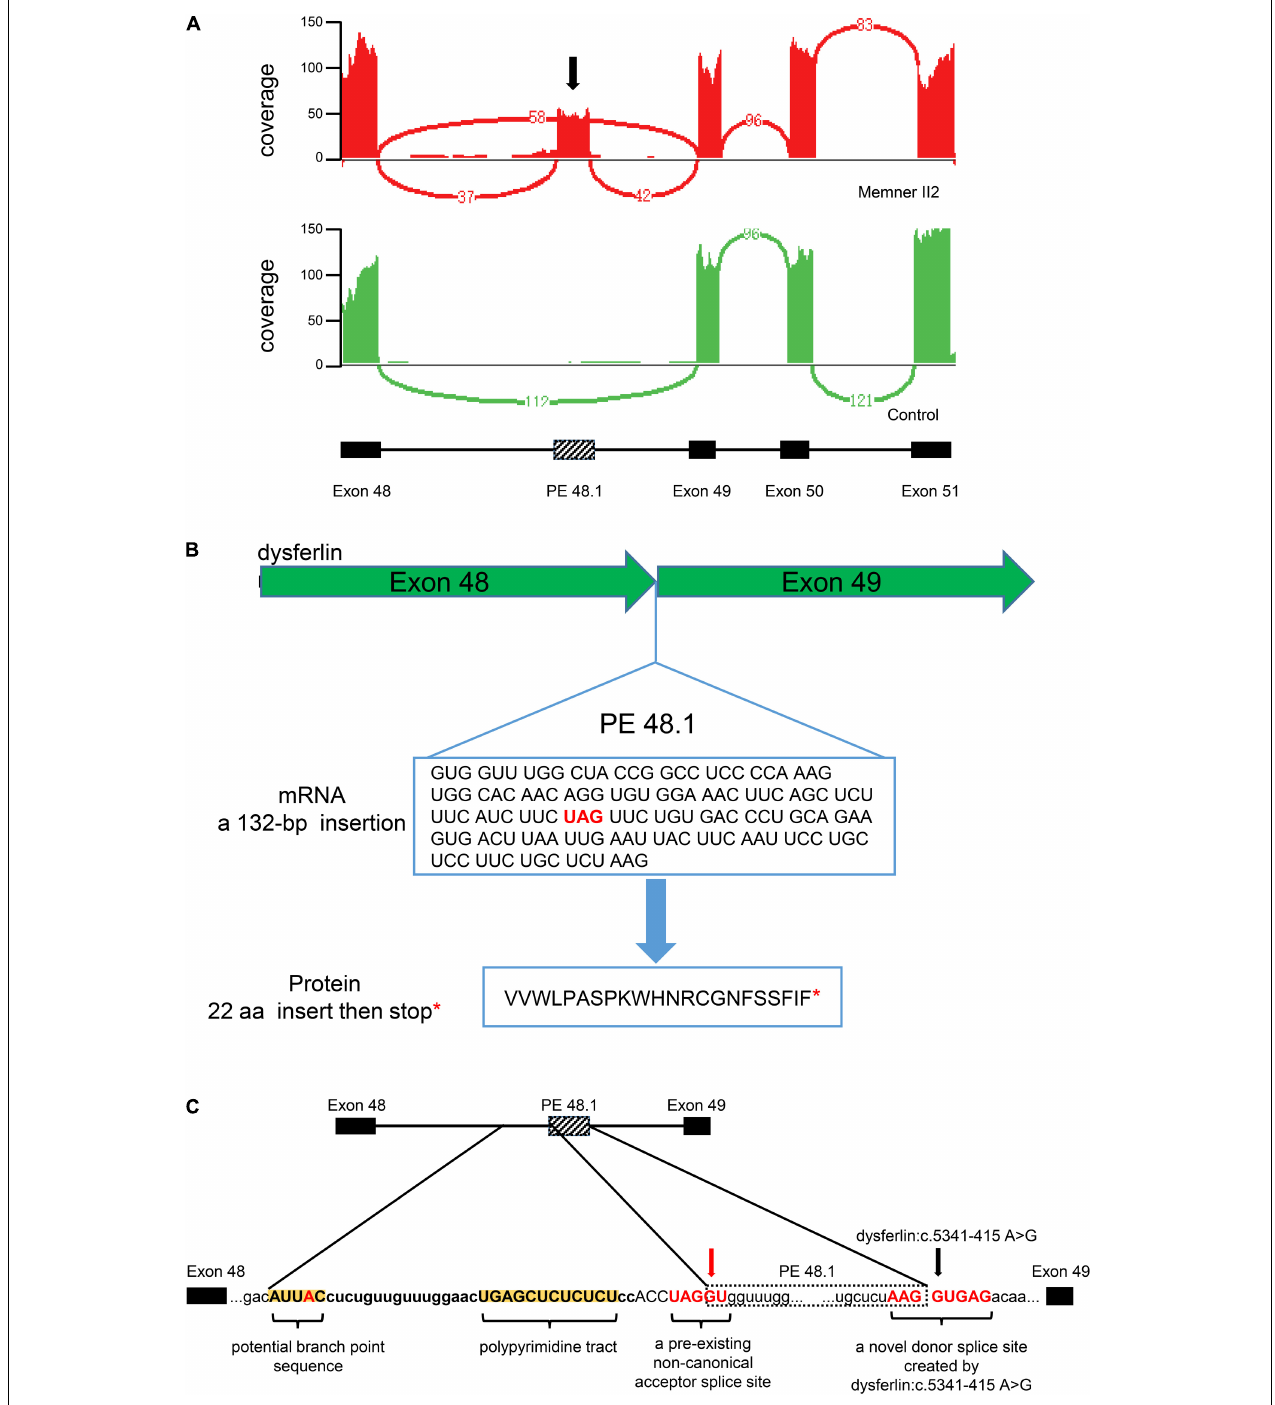
FIGURE 3 | Integrated RNA-seq and WGS identify a pathogenic deep intronic variant in the DYSF gene in the familial member II-1. (A) Sashimi plot generated using IGV illustrates RNA-Seq reads mapping to the DYSF locus. Splice junctions are displayed as arcs connecting exons. Sashimi plots generated by IGV for two RNA-Seq samples. Splicing events of the DYSF gene in the familial member II-1 and the healthy control (red and green, respectively). Exon 48, 49, 50, and 51 of the DYSF gene are shown as RefSeq annotation tracks. A pseudoexon inclusion, which we term PE 48.1, is indicated by a black arrow in Sashimi plot (red). (B) RNA-seq revealed a 132 base pair insertion, PE 48.1, between exon 48 and exon 49. PE48.1 encodes 22 additional amino acids followed by a stop codon (red asterisk). (C) WGS, which covers the entire DYSF sequence, revealed a novel donor splice site created by DYSF : c.5341-415 A > G (black arrow). The intronic sequence upstream of PE44.1 contains additional consensus sites required for mRNA splicing, including a pre-existing non-canonical acceptor splice site (red arrow), an adjacent pyrimidine-rich region (yellow highlight) and one potential branch point sequence (yellow highlight) that could be used to promote splicing.